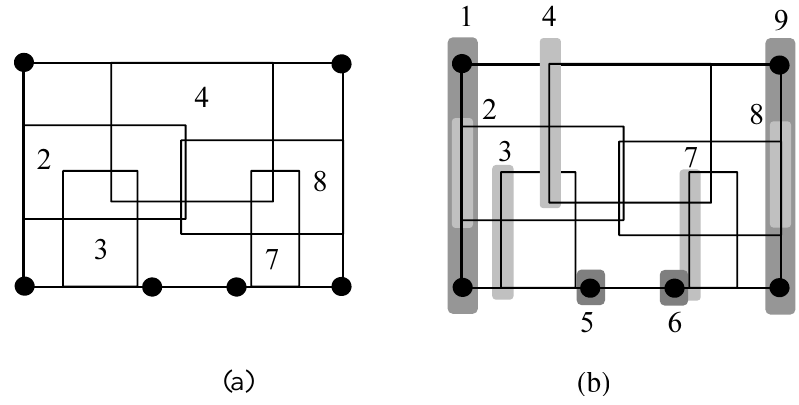
Figure 13. ( a ) An input drawing with label overlaps; ( b ) each node, vertical edge segment and label is associated with a vertical